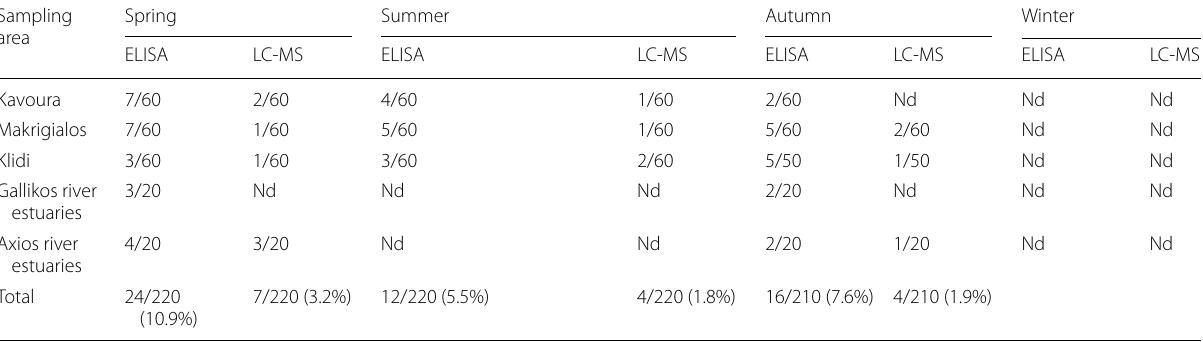
Nd not detected